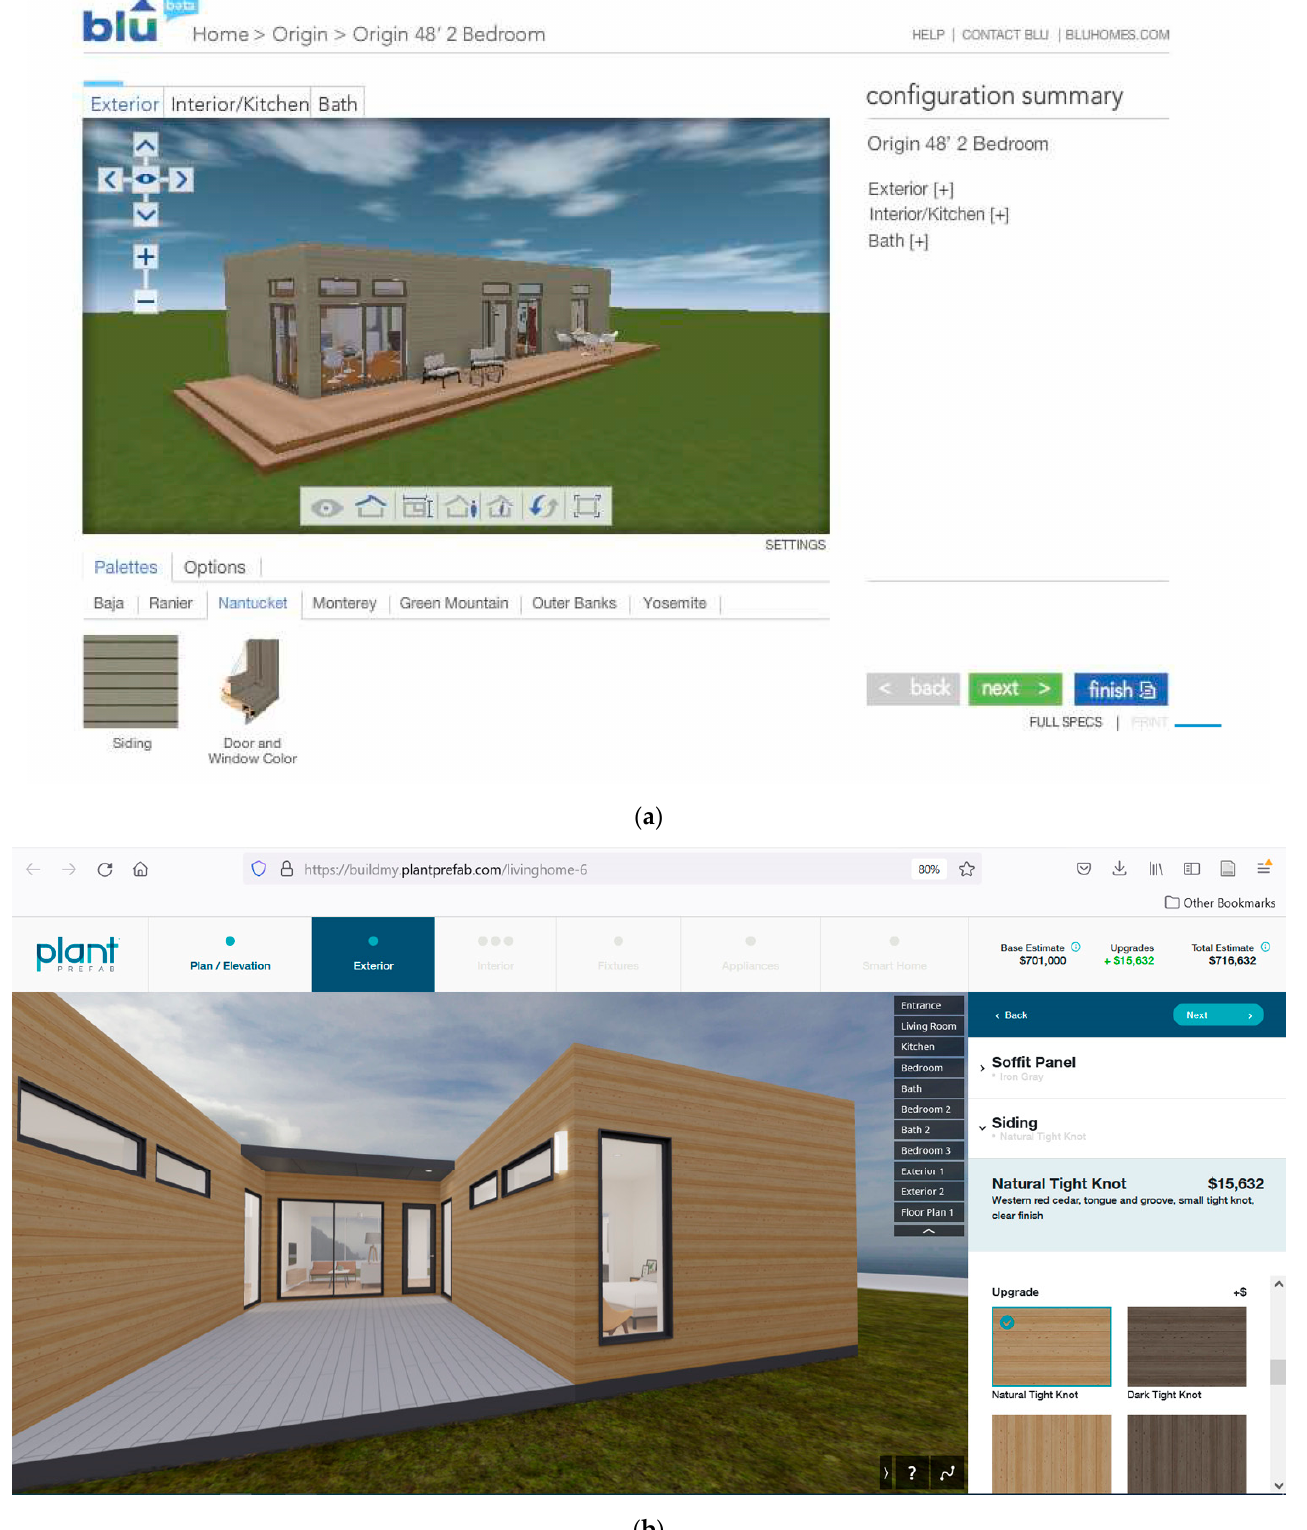
Figure 3. ( a ) A printscreen of the configuration system by two companies in the US market, Livinghomes and bluhomes . ( b ) A recent screenshot of planprefab (livinghomes) with a more advanced 3D configurator.